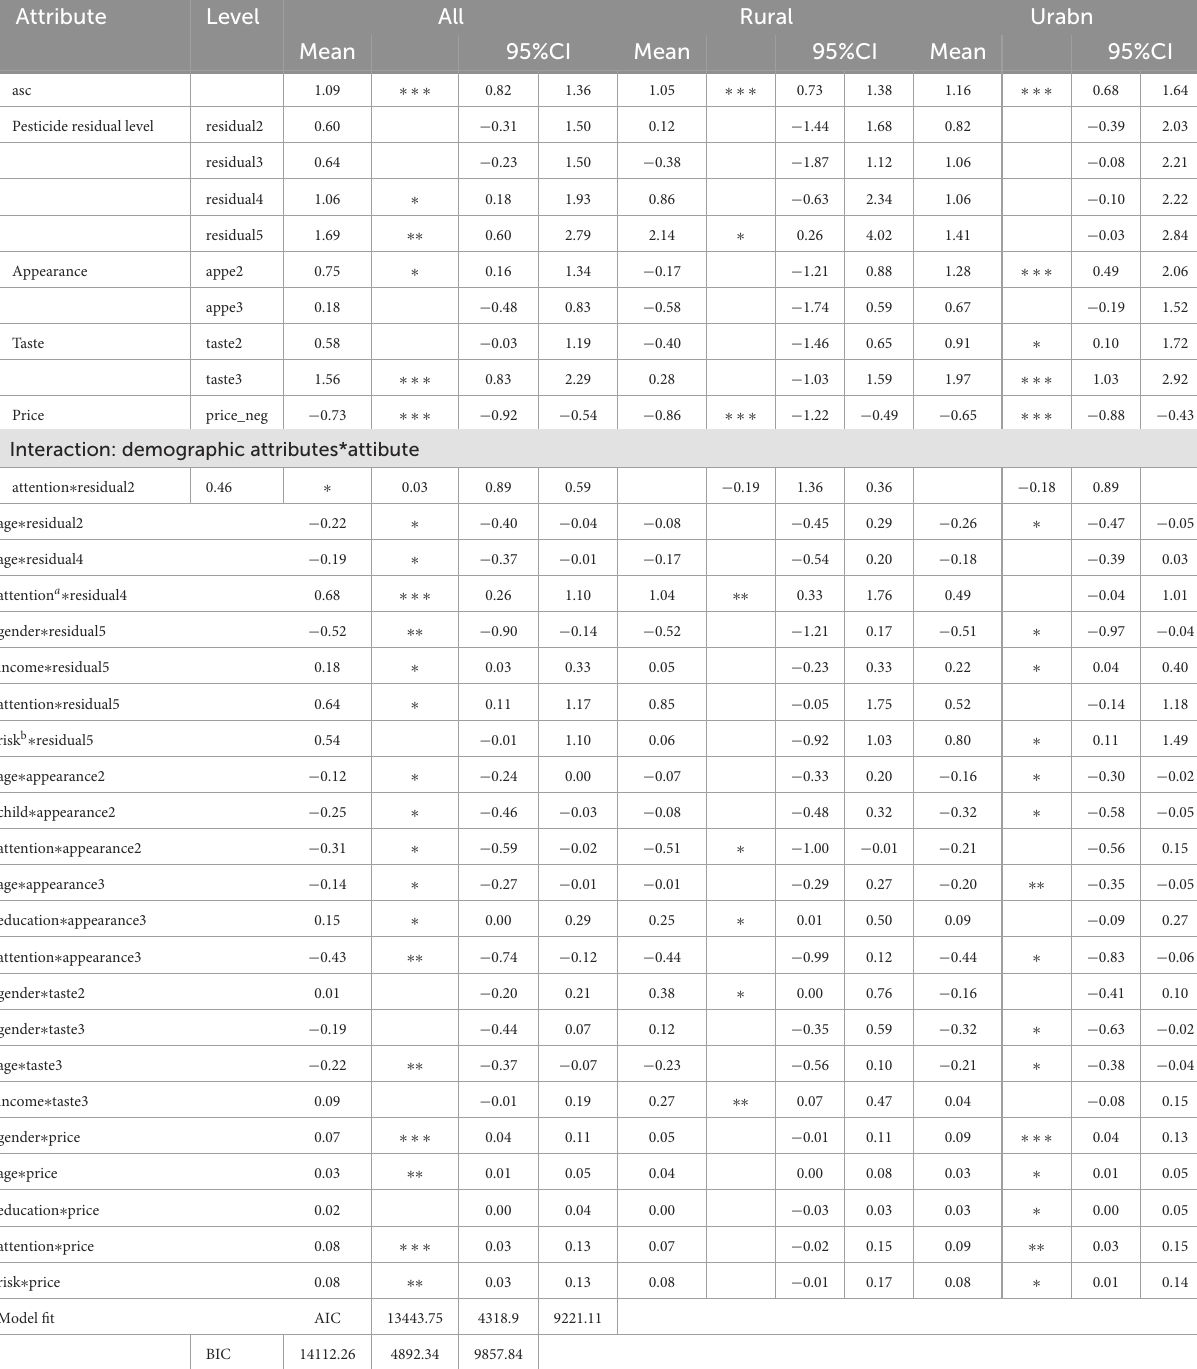
TABLE 6 Results of the preference heterogeneity analysis.